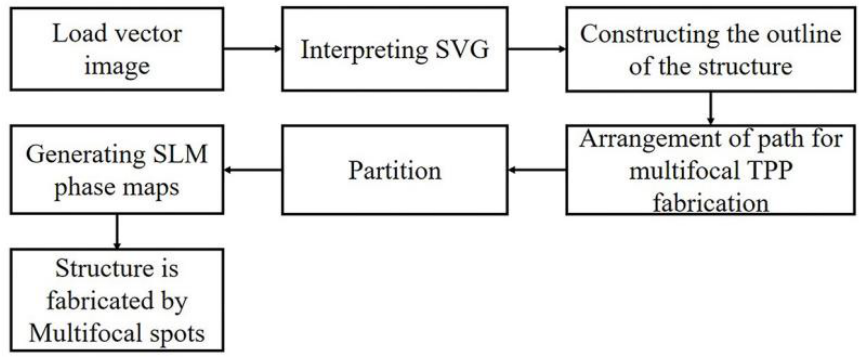
Figure 1. Schematic diagram of the fabrication of large complex vector structures.